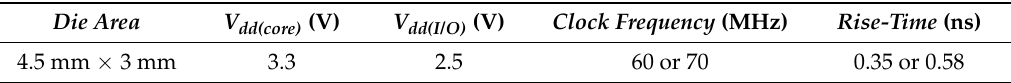
Table 1. Dimensions and nominal values for the studied IC.